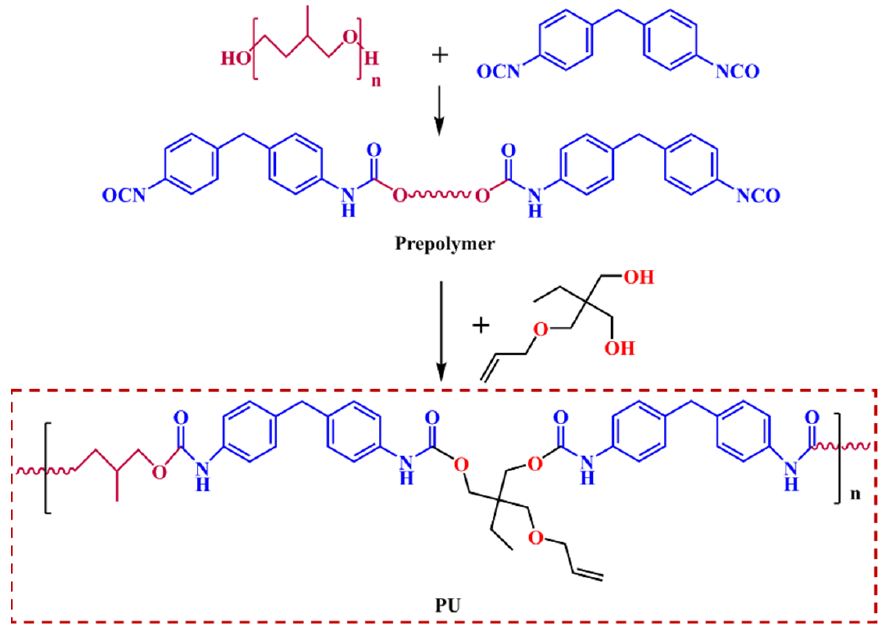
Figure 9. The synthetic route of the PU ‐ based composite. Fourier transform infrared (FTIR) spectra of the PU ‐ based composite were tested in attenuated total reflection mode on an FTIR spectrophotometer with a resolution of 4 cm − 1 (Tensor 27, Bruker, Germany). Figure 10a shows the appearance of the absorption peak of the imino (N ‐ H) (3300 cm − 1 ), hydrocarbon (2900 cm − 1 ), and ether groups ( ‐ O ‐ ) (1100 cm − 1 ). Additionally, the absorption peak of isocyanate group ( ‐ NCO) (2300 cm − 1 ) disappeared. Combined with the result of GPC curve in Figure 10b, it was clear that the PU ‐ based